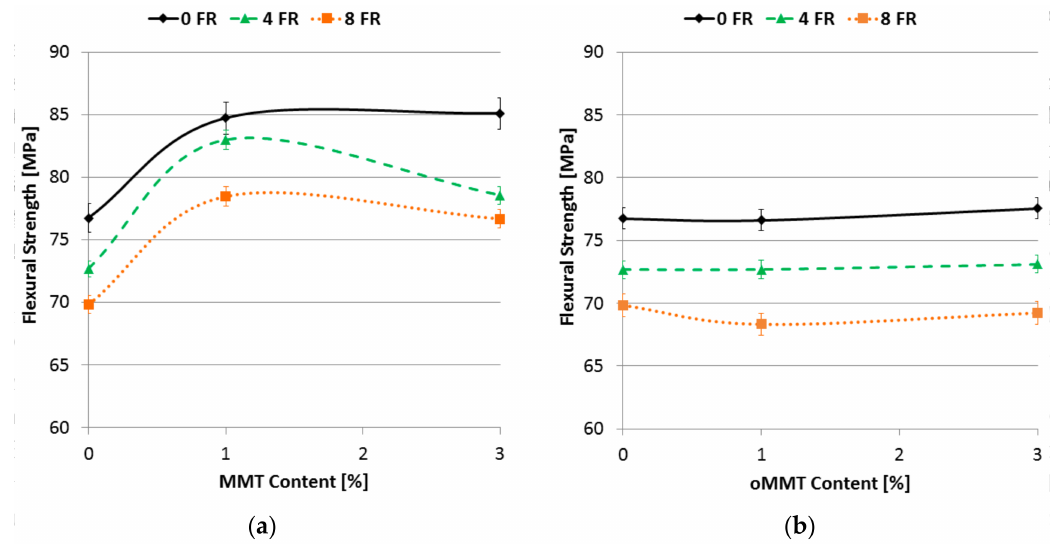
Figure 11. Flexural strength as a function of filler content: ( a ) MMT filler; ( b ) oMMT filler.